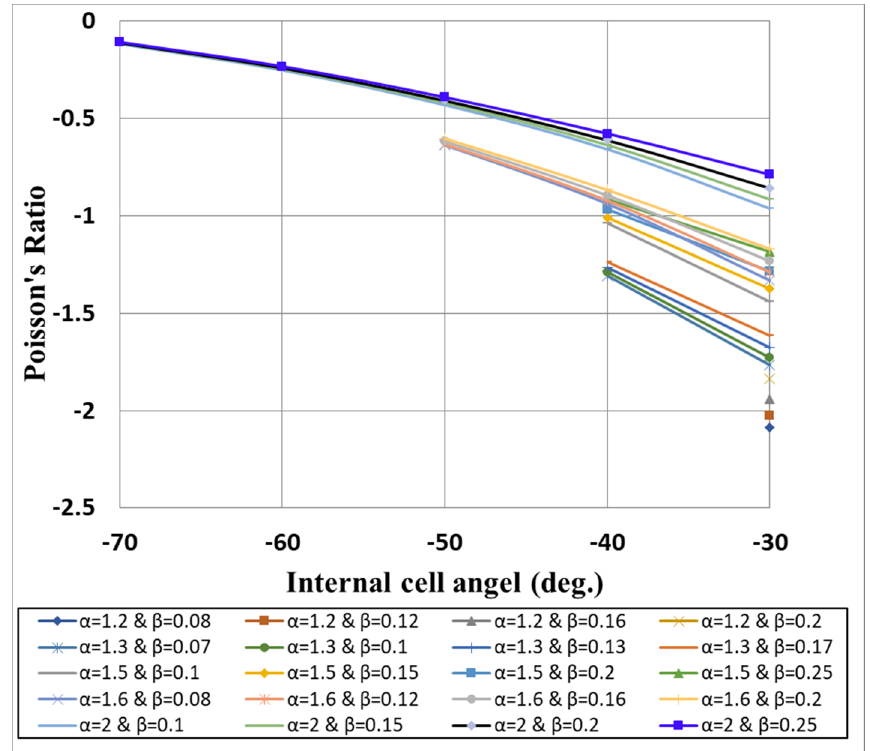
Figure 10. In-plane Poisson’s ratio calculations as a function of cell dimensions.